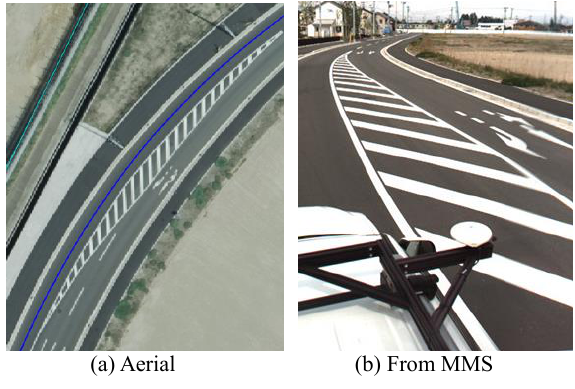
Figure 10. Processing area photos